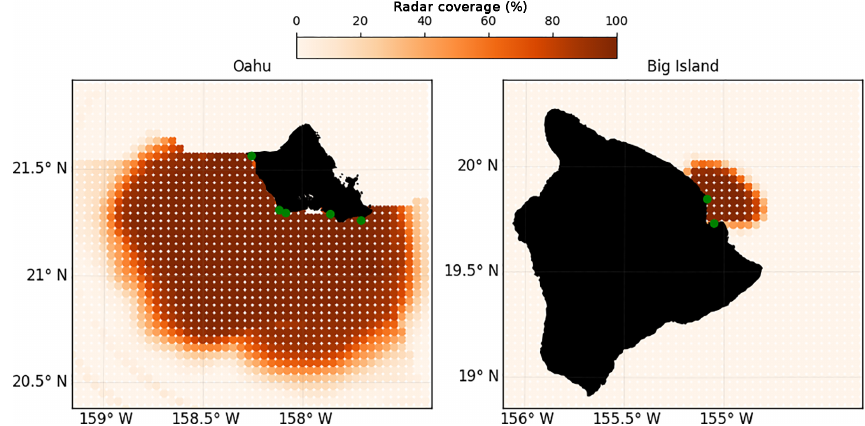
Figure 2. Composite image of percentage coverage for all radar sites (situated at green dots) when all are operational. Where two sites overlap the greater value is taken to indicate the level of coverage at each point.